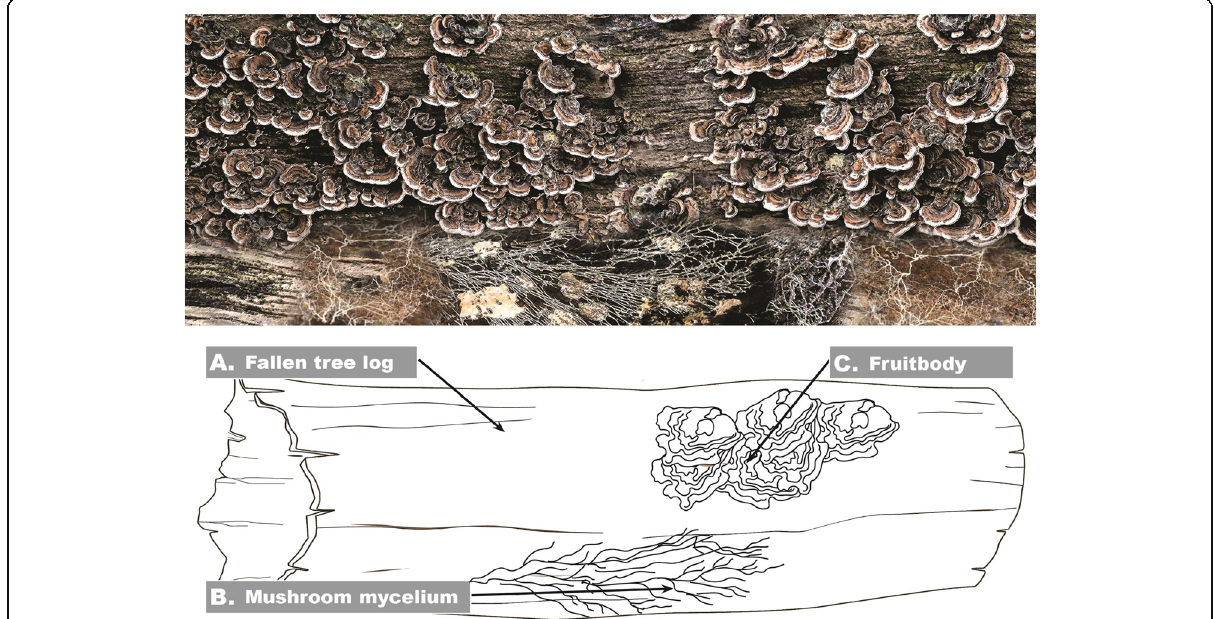
Fig. 1 Decomposition of a fallen tree log by Trametes versicolor (Tv). a Fallen tree log, presenting fresh organic plant matter. b Tv mycelium is growing inside the log, decomposing the plant biomass by fermentation, in a highly dynamic exchange of solubilized nutrients from the tree log, resulting from secreted fungal enzymes, combined with anti-microbial defense compounds to protect the mycelial territory. c Fruitbodies serve to spread the spores of the Tv mushrooms, and have a narrower chemical composition, focused on beta-glucans, spores, attractants to animals that may eat and transport the spores, and protectants to protect the fruitbodies from bacteria and other